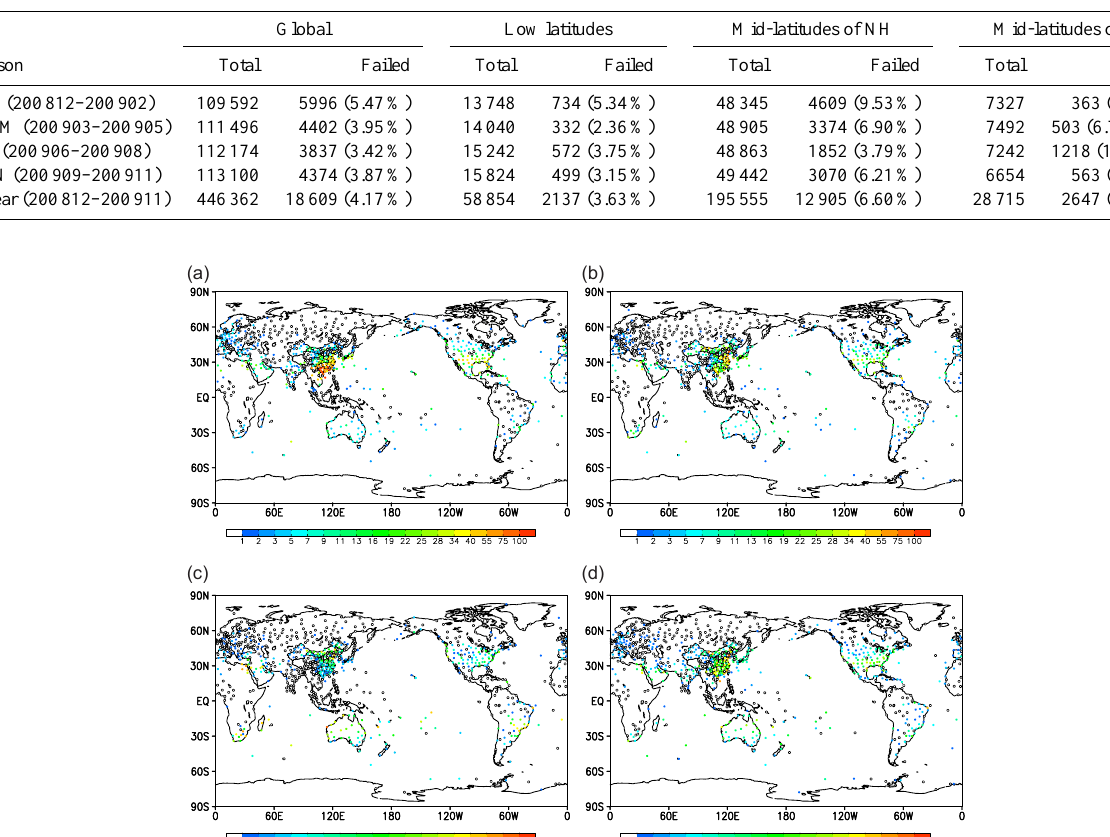
Figure 3. As in Fig. 2, but separated into four seasons: (a) DJF (December, January, February); (b) MAM (March, April, May); (c) JJA (June, July, August); (d) SON (September, October, November).